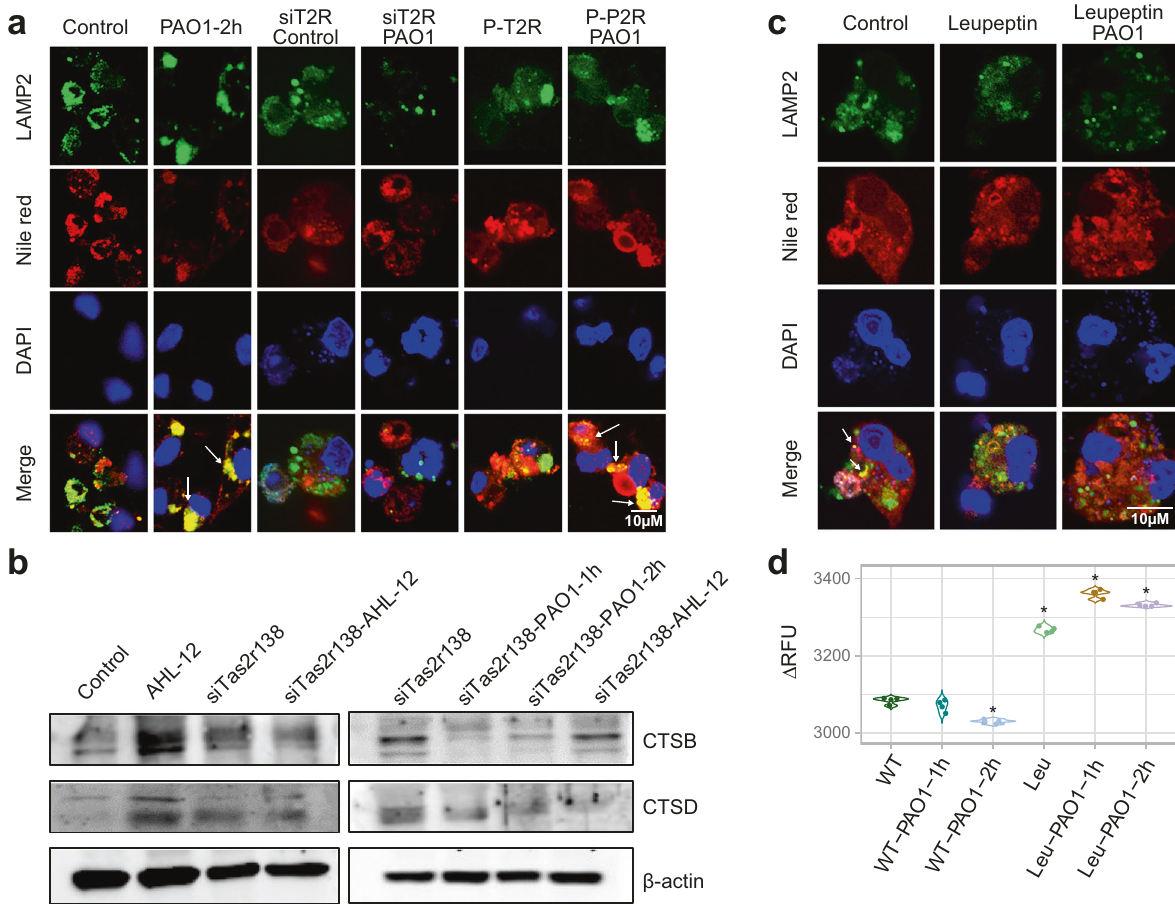
Fig. 3 LDs entered into lysosomes. a WT or Tas2r138 siRNA-transfected neutrophils were infected with PAO1 (MOI: 5:1) or AHL-12 (50 μ M) stimulated for 2 h. The LDs (stained by Nile red) and LAMP2 (green) were detected by immuno fl uorescence imaging (arrows showing the typical proteins colocation). b WT or Tas2r138 siRNA-transfected neutrophils were infected with PAO1 (MOI: 5:1) or AHL-12 (50 µM) stimulated for 2 h. The expression of CTSB, CTSD, and β -actin was tested by western blotting. c Neutrophils were incubated with 20 µM leupeptin for 24 h to inhibit lysosome function. Then the cells were infected with PAO1 (MOI: 5:1) for 2 h. The LDs (stained by Nile red) and LAMP2 (green) expression were detected by immuno fl uorescence imaging (arrows show the colocation between LAMP2 and LDs decrease). d Neutrophils were incubated with 20 µM leupeptin for 6 h, then the cells were infected with PAO1 (MOI: 5:1) for 2 h. Cells were fi xed by 4% paraformaldehyde and permeabilized with 0.2% Triton-X 100 for 15 min. The LDs were stained by Nile red for 2 h. After washed by PBS, the fl uorescence intensity was measured by Bio-Tek fl uorescence plate reader (530/25, 590/35). The results were expressed as the mean ± SD and the signi fi cant difference level between two groups was de fi ned by one-way ANOVA with Tukey post hoc tests, * p <